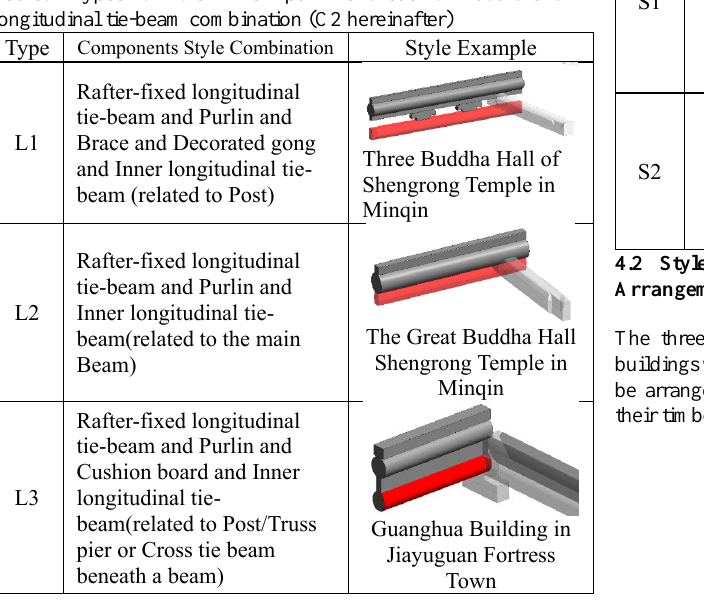
Table.2 types of the inner purlin-and-cushion board-and- longitudinal tie-beam combination (C2 hereinafter)